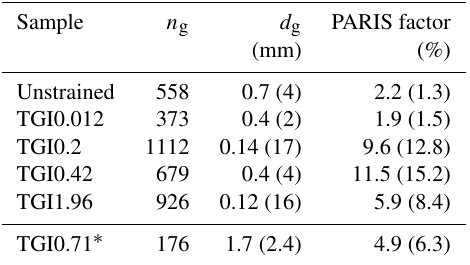
Table 2. Grain size and shape analysis results based on AITA mea- surements. The sample that was annealed is indicated by an asterisk. n g is the number of grains used for the analyses and d g the median of the grain size (with associated interquartile range). Standard de- viations are indicated in